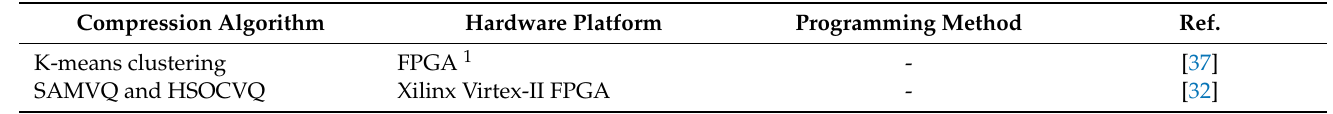
Table 7. List of studies on VQ-based compression systems of hyperspectral images and their hardware platforms.